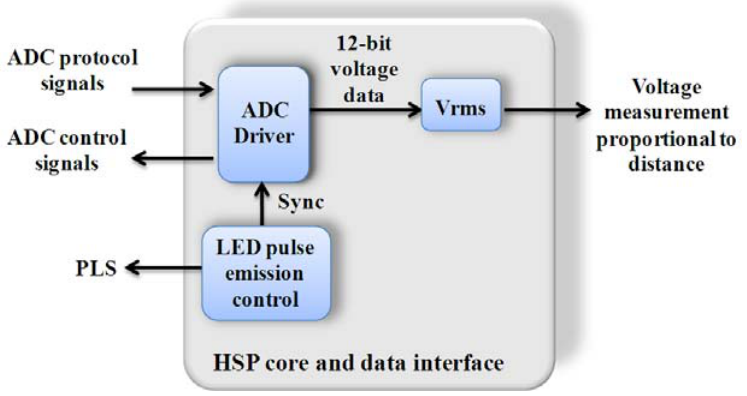
Figure 8. Block diagram for micropositioning measurement utilizing the HSP core.